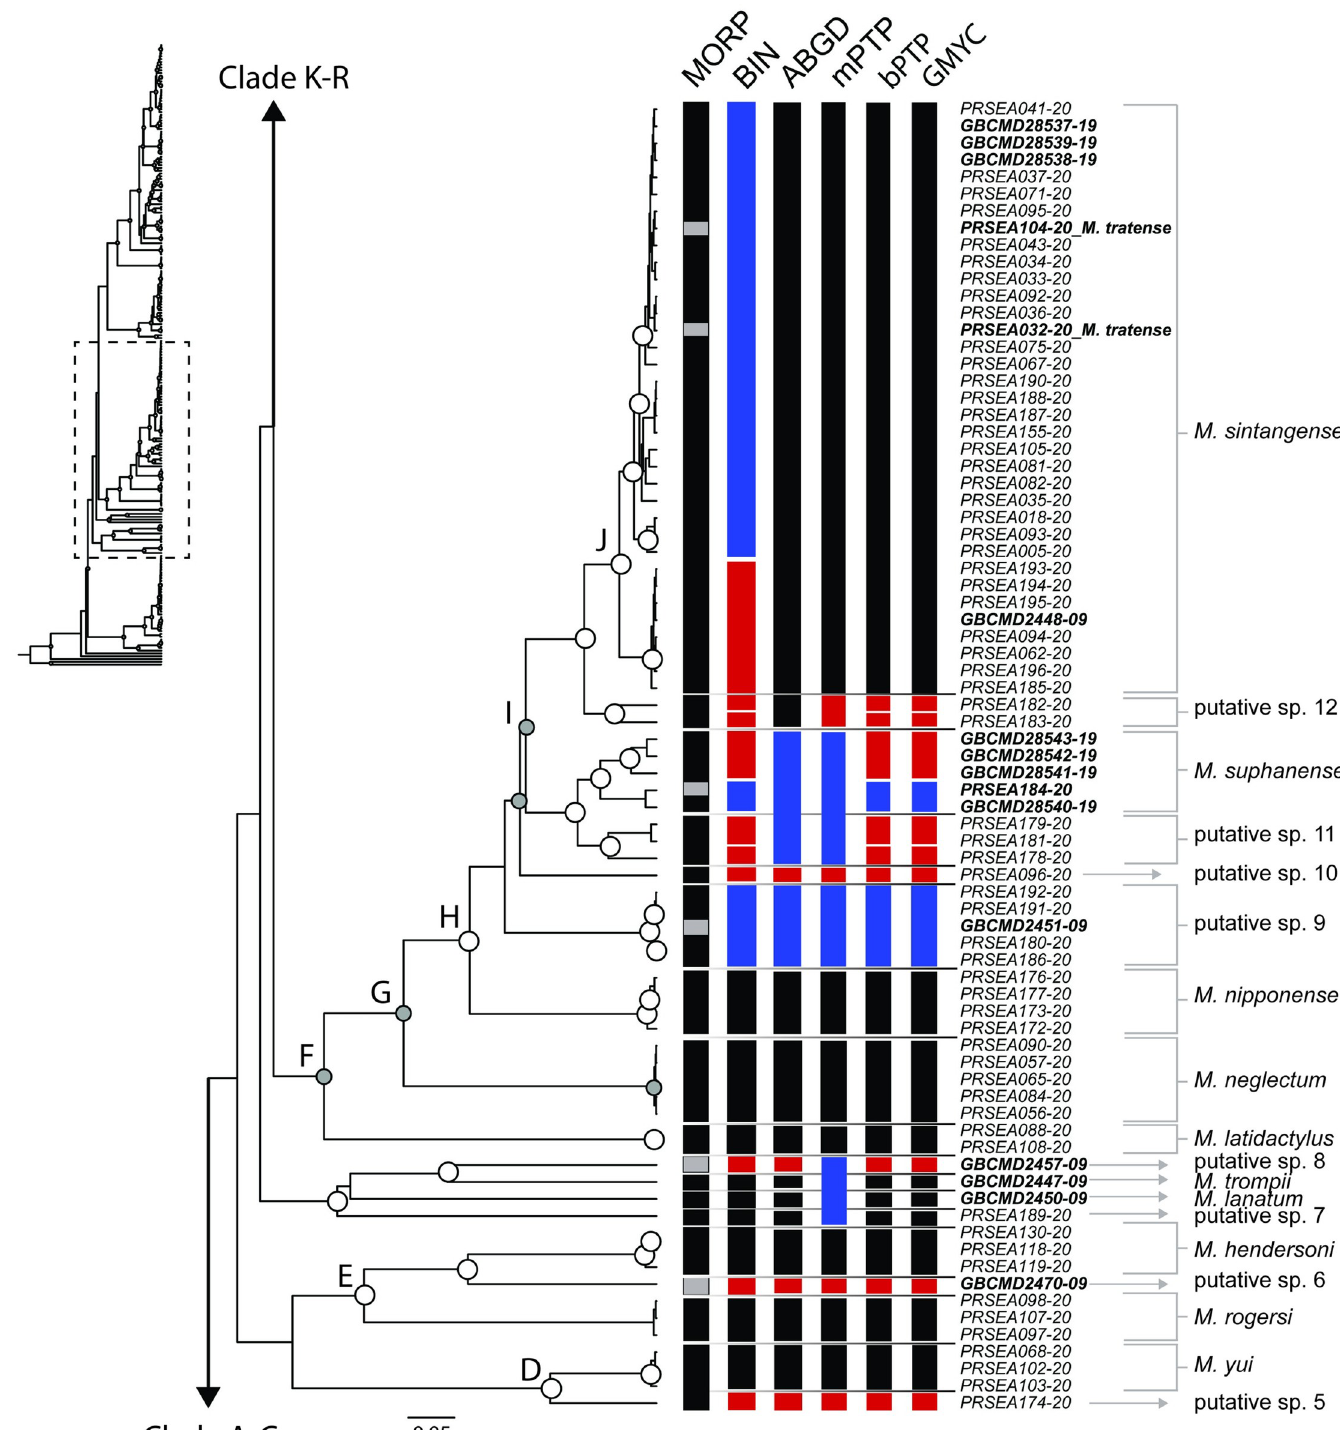
Fig 4. Ultrametric tree of Indochinese Macrobrachium indicating clade support level and species delimitation clustering results (part 2). For abbreviations used on tree see Fig 3.